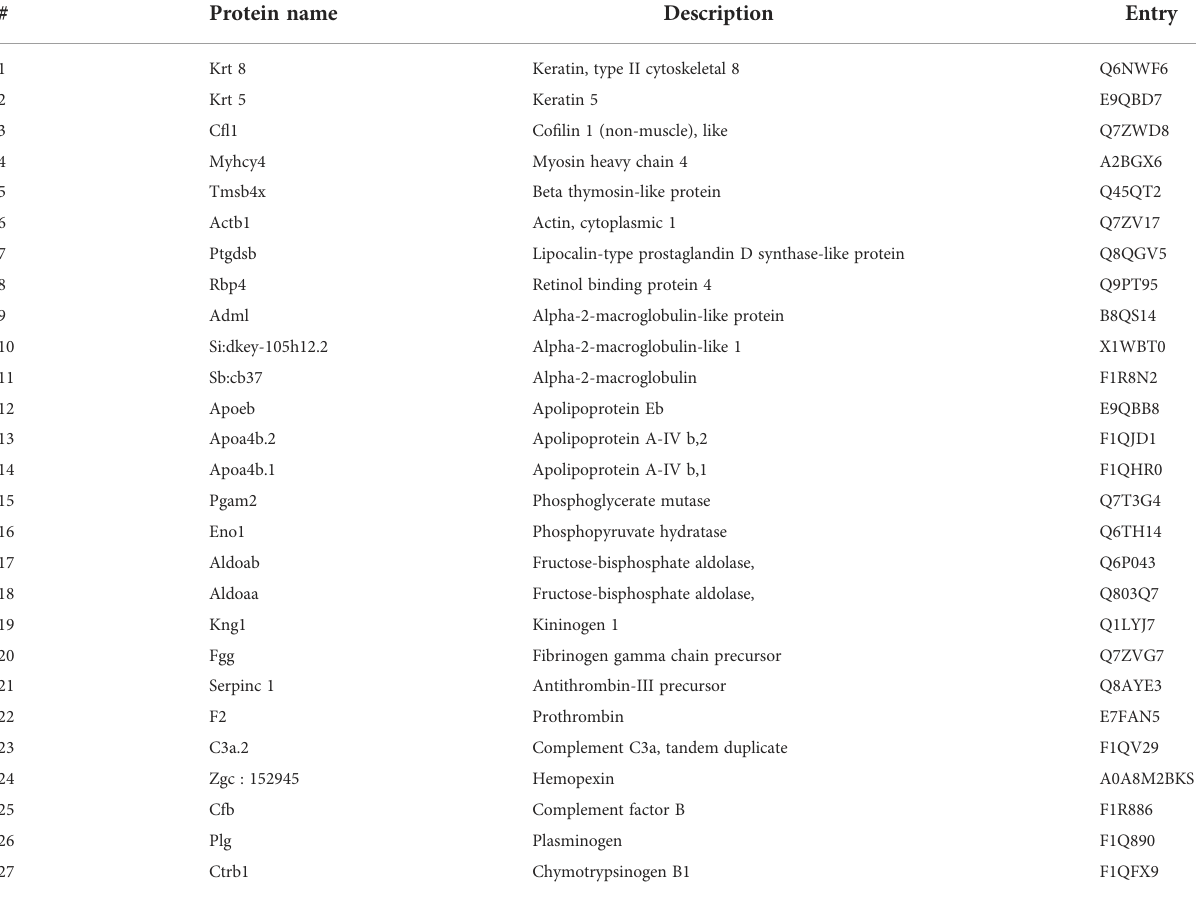
TABLE 1 Retrieved details for the 27 most abundant proteins identi fi ed in zebra fi sh plasma after 4h of the l -CGN-induced in fl ammatory